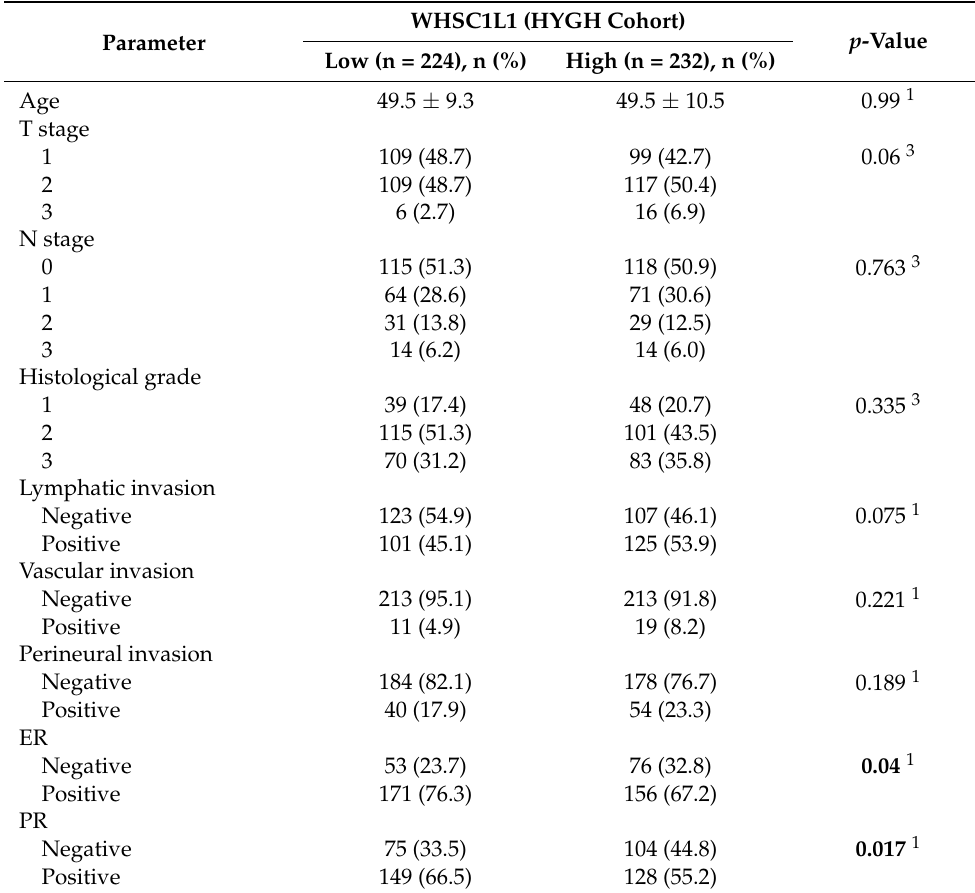
Table 1. Clinicopathological parameters of WHSC1L1 (Wolf-Hirschhorn syndrome candidate 1-like protein 1) in HYGH